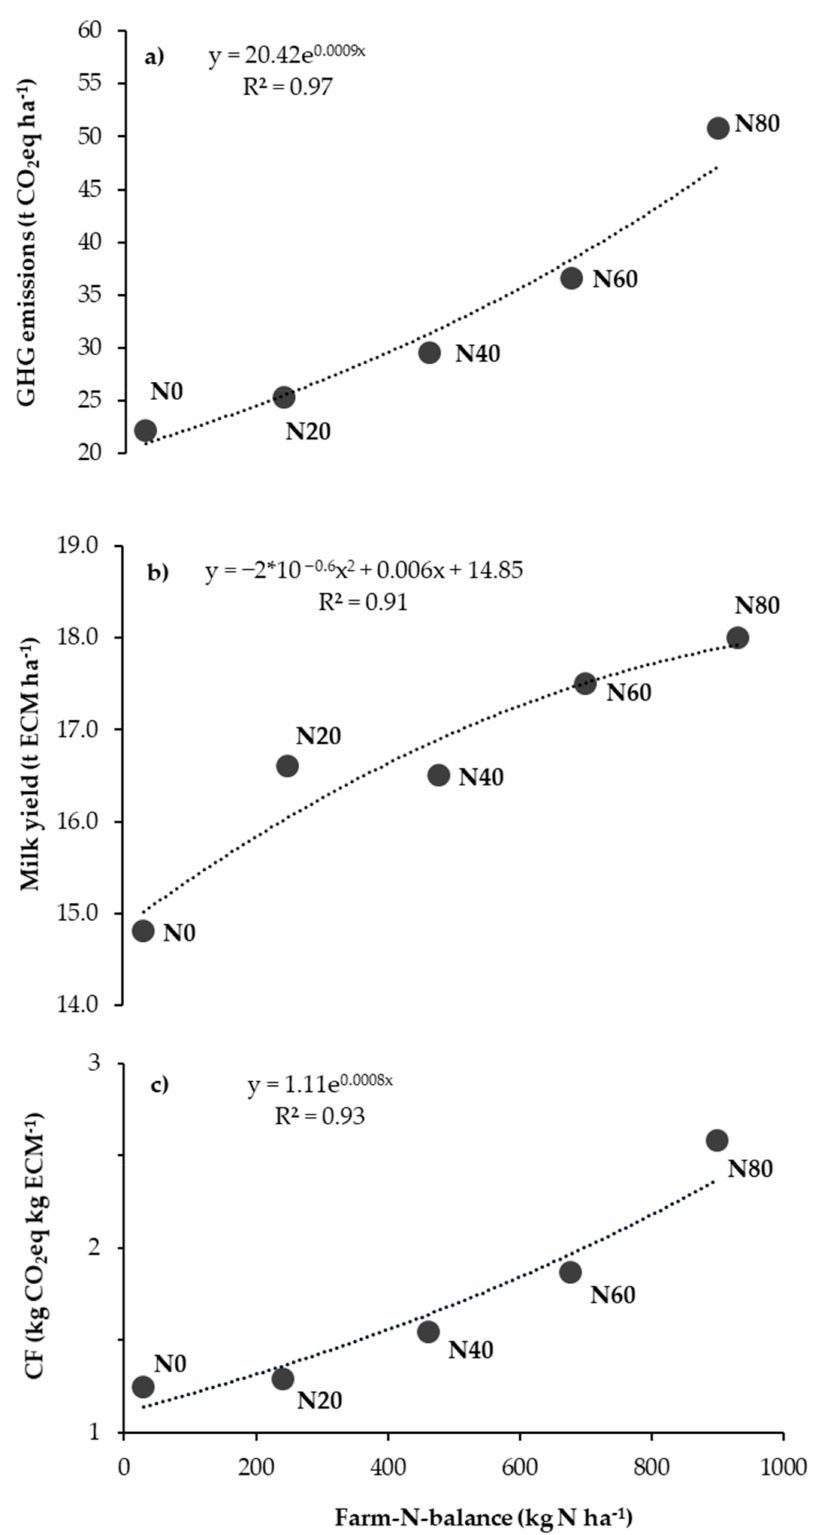
Figure 2. The relationship between ( a ) GHG Emissions (t CO 2 eq ha − 1 ), ( b ) milk yield (t ECM ha − 1 ) and ( c ) CF (kg CO 2 eq kg ECM − 1 ) in relation to the farm-N-balance (kg N ha -1 ) between the different treatments (N0, N20, N40, N60 and N80). Soil carbon changes were considered. Means for the three experimental years are shown (n =